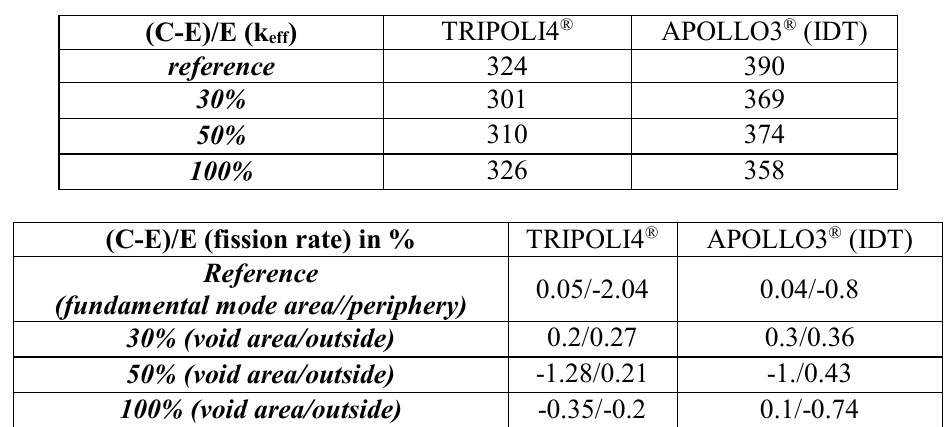
Table I. UH1.2 (C-E/E) results : keff (pcm) and fission rate